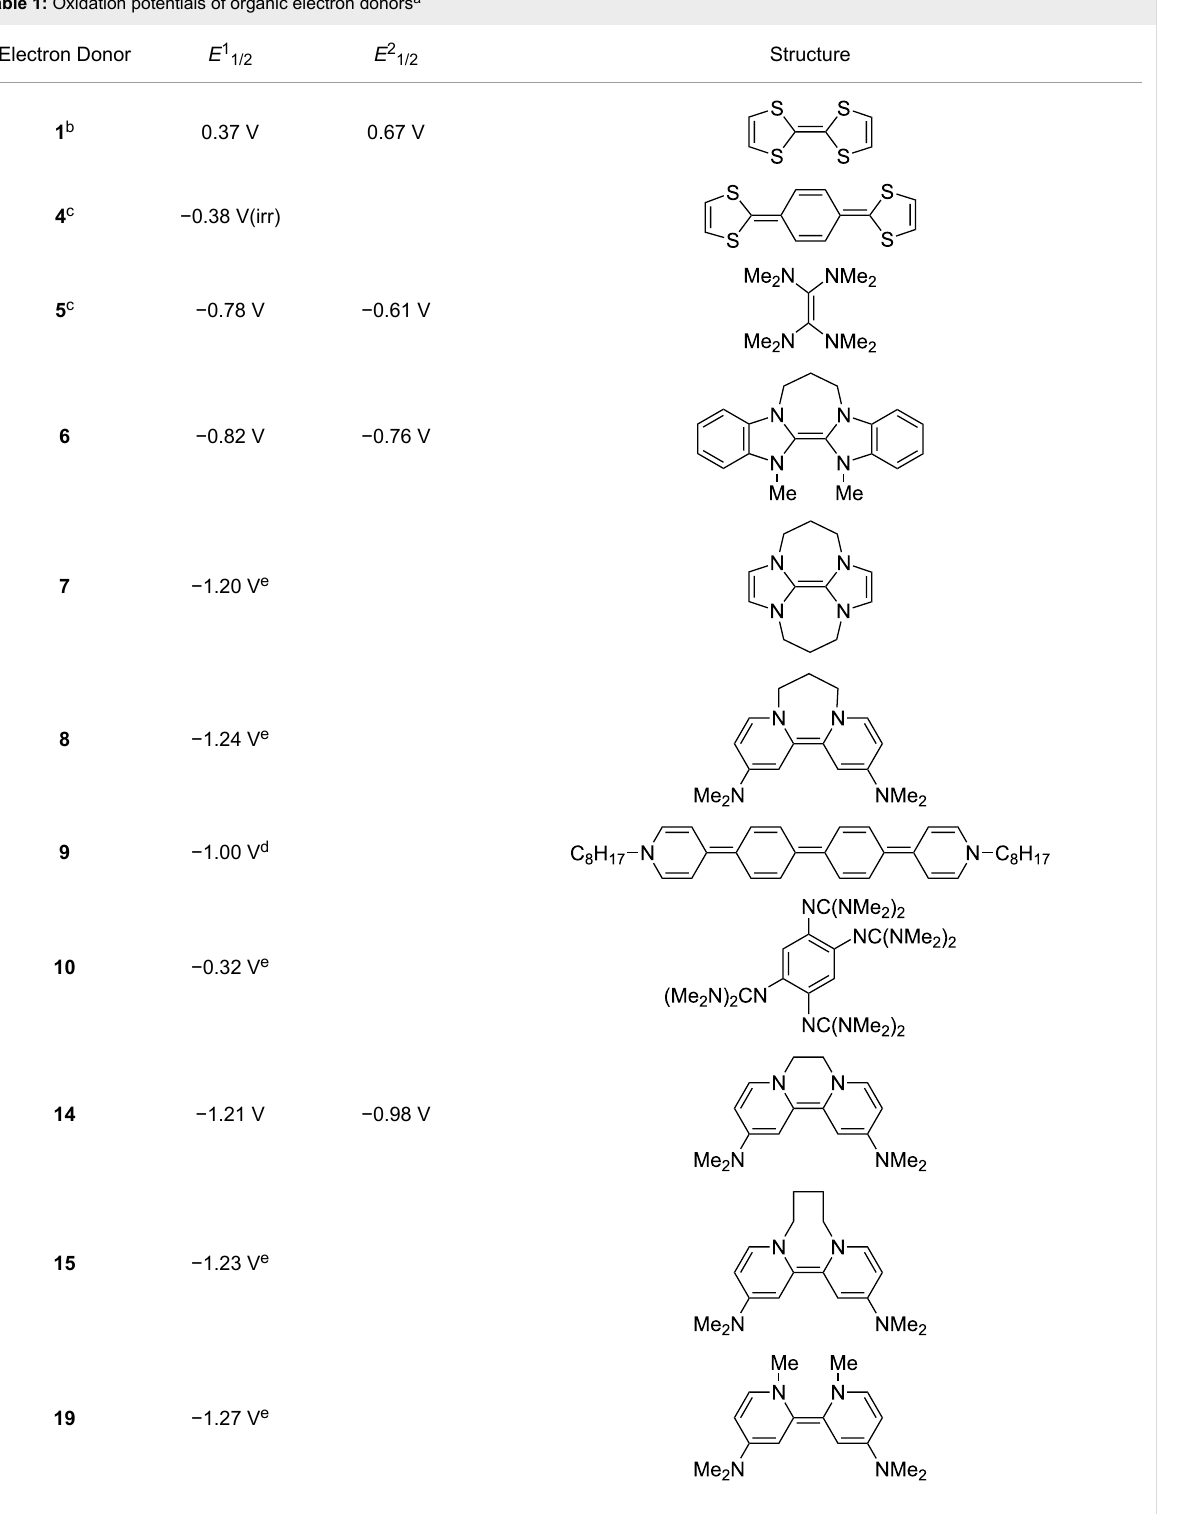
Table 1: Oxidation potentials of organic electron donors a